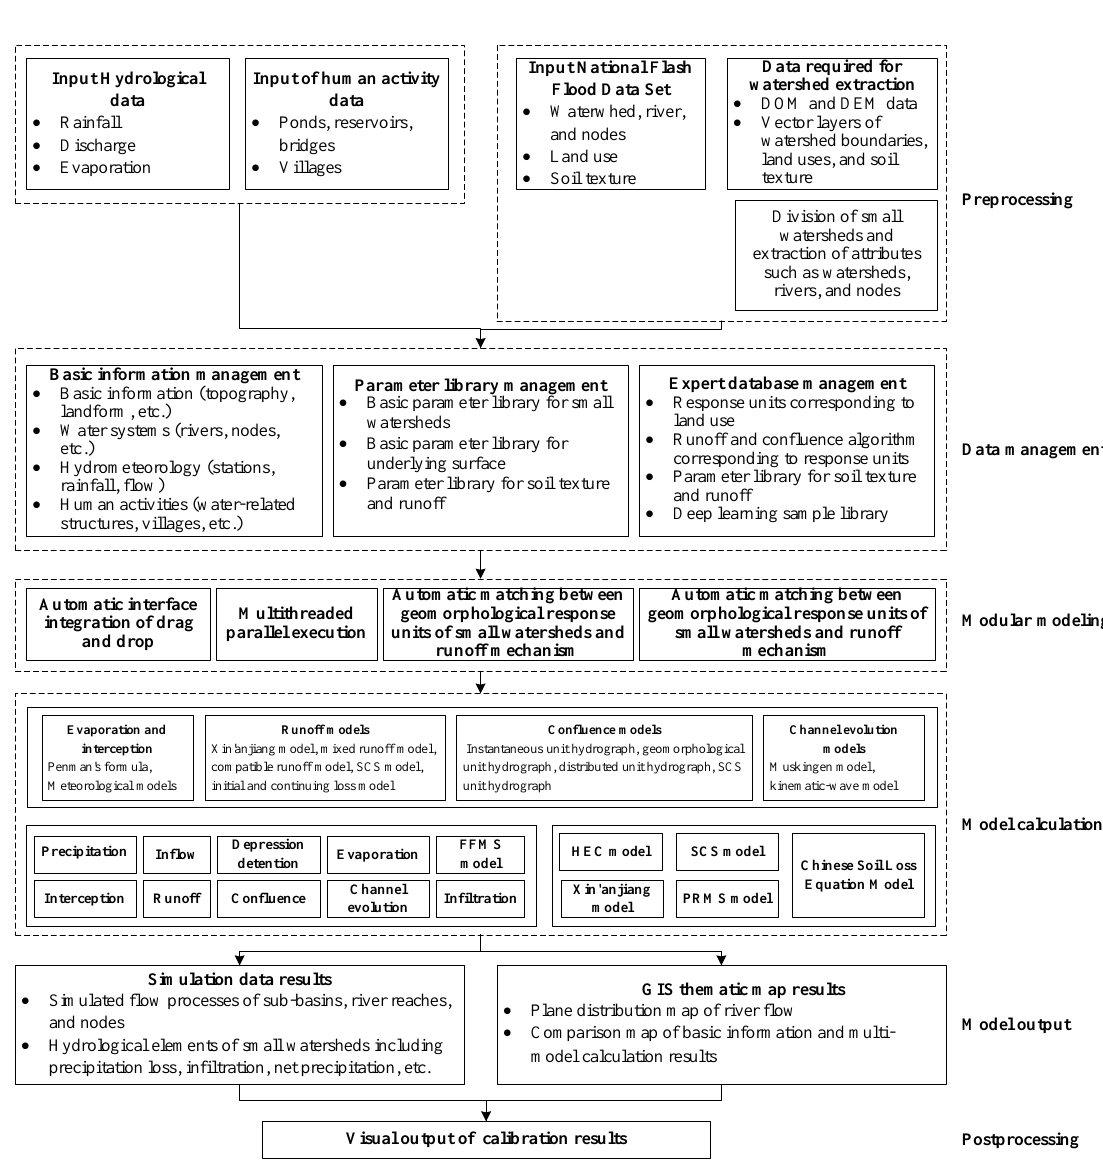
Figure 4. FFMS software architecture and functional modules.